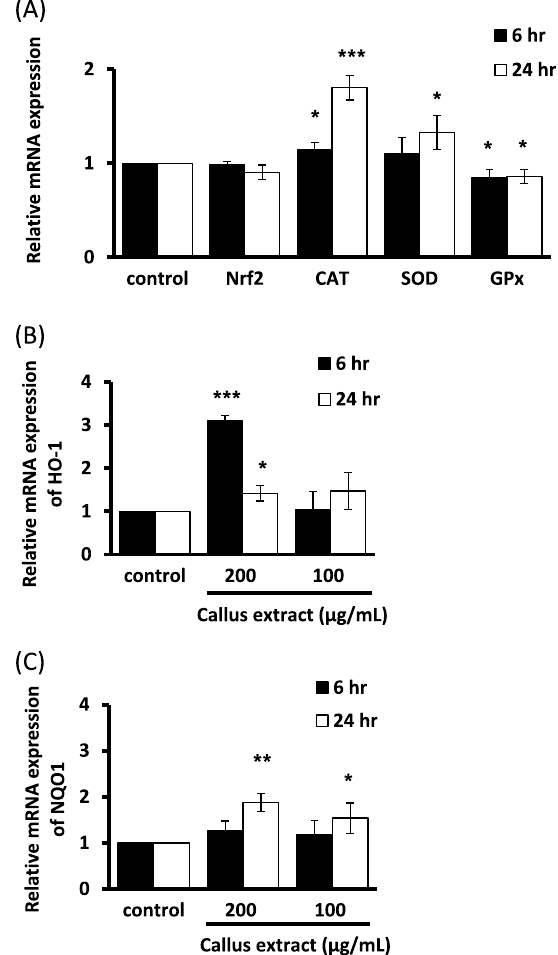
Fig. 5 The mRNA expression levels of antioxidant genes were measured in HaCaT keratinocytes. A mRNA expression levels of four antioxidation‑related genes, Nrf2, CAT, SOD, and GPx, in cells treated with 200 μg/mL of callus extract for 6 h and 24 h. B HO‑1 mRNA expression in cells treated with 100 μg/mL and 200 μg/mL for 6 h and 24 h. C NQO1 mRNA expression in cells treated with 100 μg/mL and 200 μg/mL for 6 h and 24 h. Data are presented as means triplicate experiments. * p < 0.05, ** p < 0.01, and *** p < 0.001 compare with